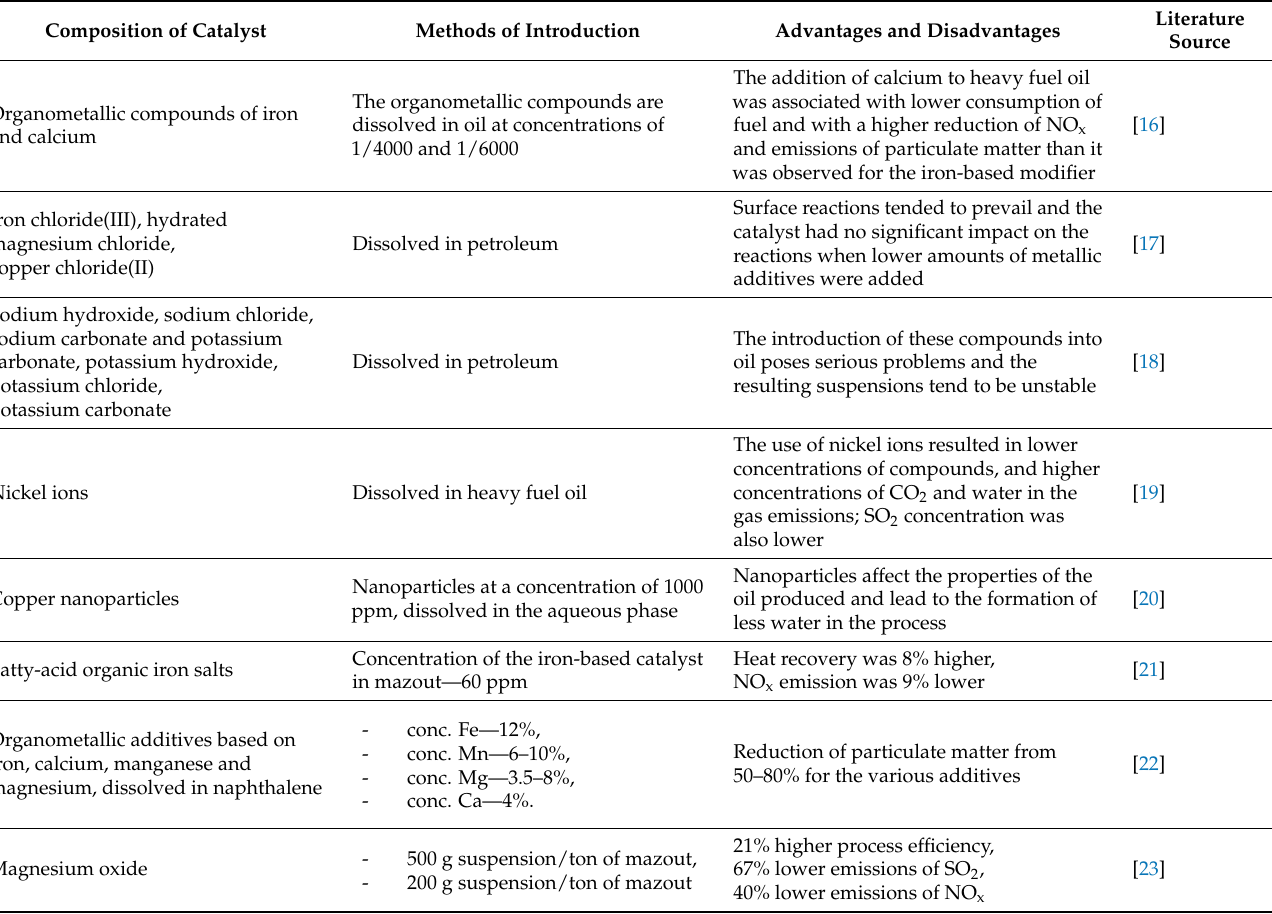
Table 1. Additives used with fuel oil (own analysis based on the